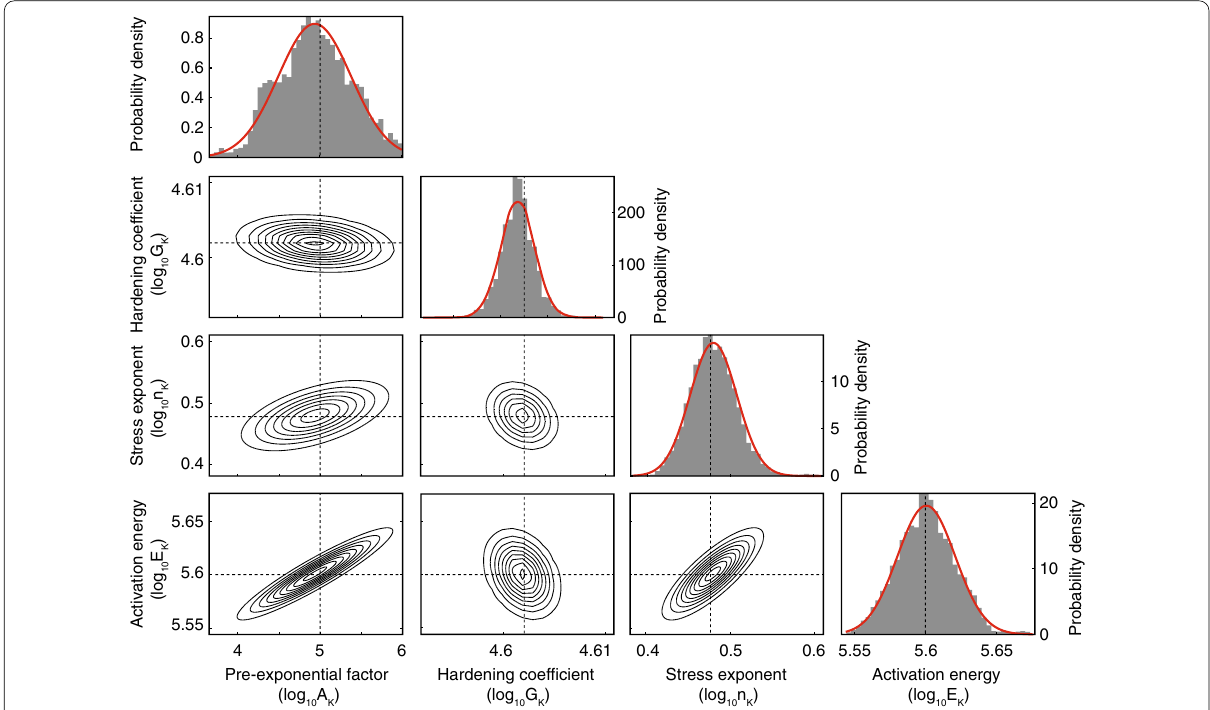
Fig. 2 Gibbs sampling benchmark. We generate synthetic data using similar thermodynamic conditions to those of the experimental data using A K = 10 5 s − 1 MPa − n K , G K = 10 4.602 MPa, n K = 10 0.477 , and E K = 10 5.6 kJ/mol. We generate 2 × 10 5 samples and discard the initial 10 4 samples. The histograms are formed using every 100 th samples of the remaining set. The mean of the marginal distribution matches the true value (dashed black line) from which the synthetic data were